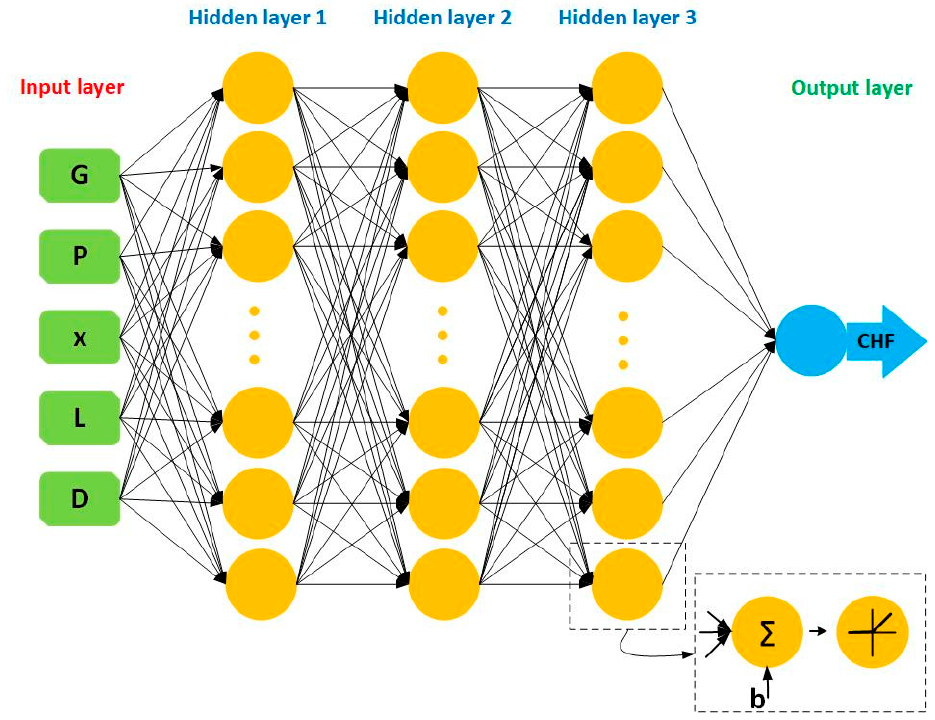
Figure 2. Architecture of ANN .